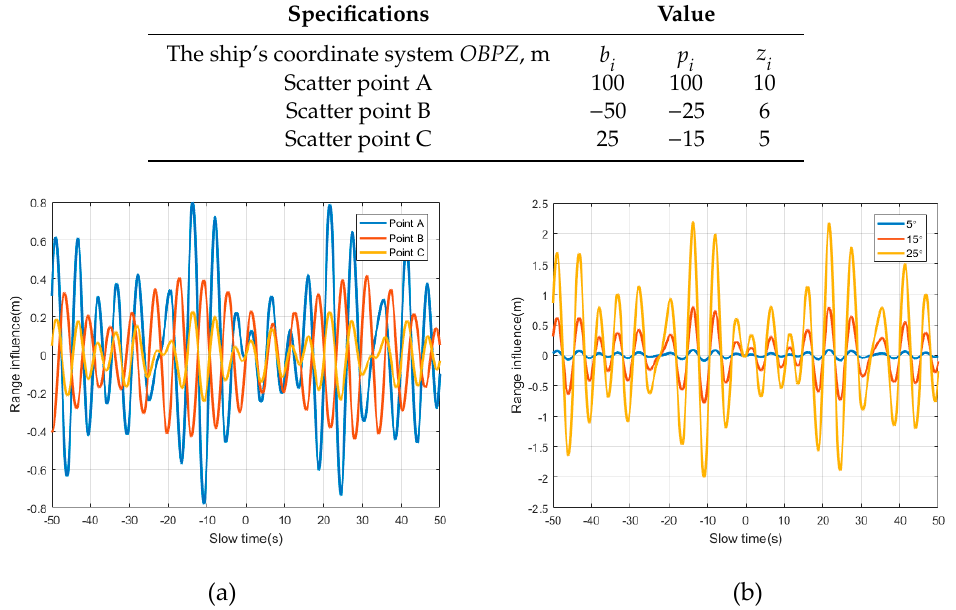
Figure A3. The influence of rotational motion on the slant range: (a) when Θ r , p , y = 15 ◦ , the influence on scatter points A, B, and C; (b) when Θ r , p , y = 5 ◦ , 15 ◦ , and 25 ◦ , the influence on scatter point